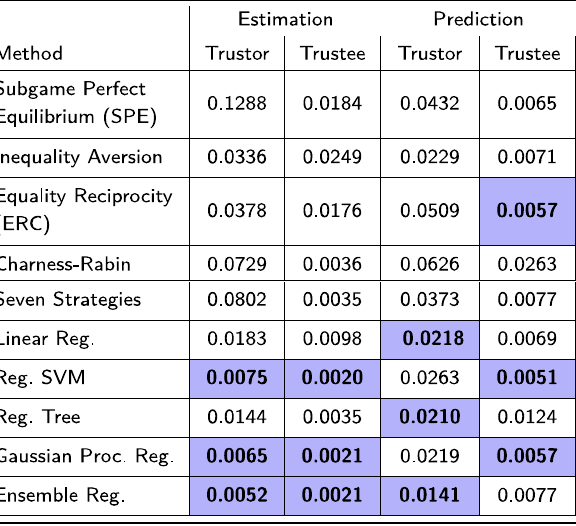
Table 4: Mean squared error for trust and trust ful fi llment: All regressions were run at least initially with all Seven Strategy and interdependence variables. The three best performers along each category are highlighted